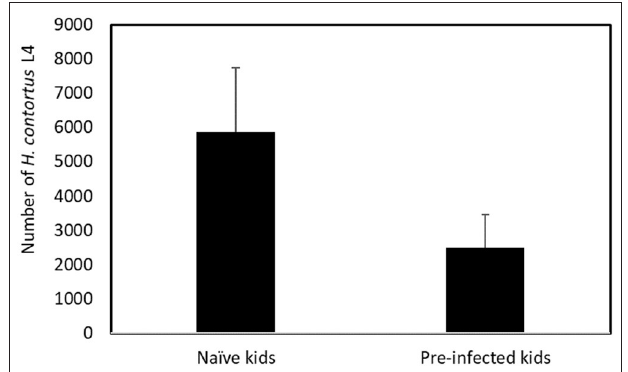
FIGURE 1 | Mean number of Haemonchus contortus fourth–stage (L4) larvae recovered from naïve and pre–infected kids at 6 days post–infection. Means are significantly different ( p <